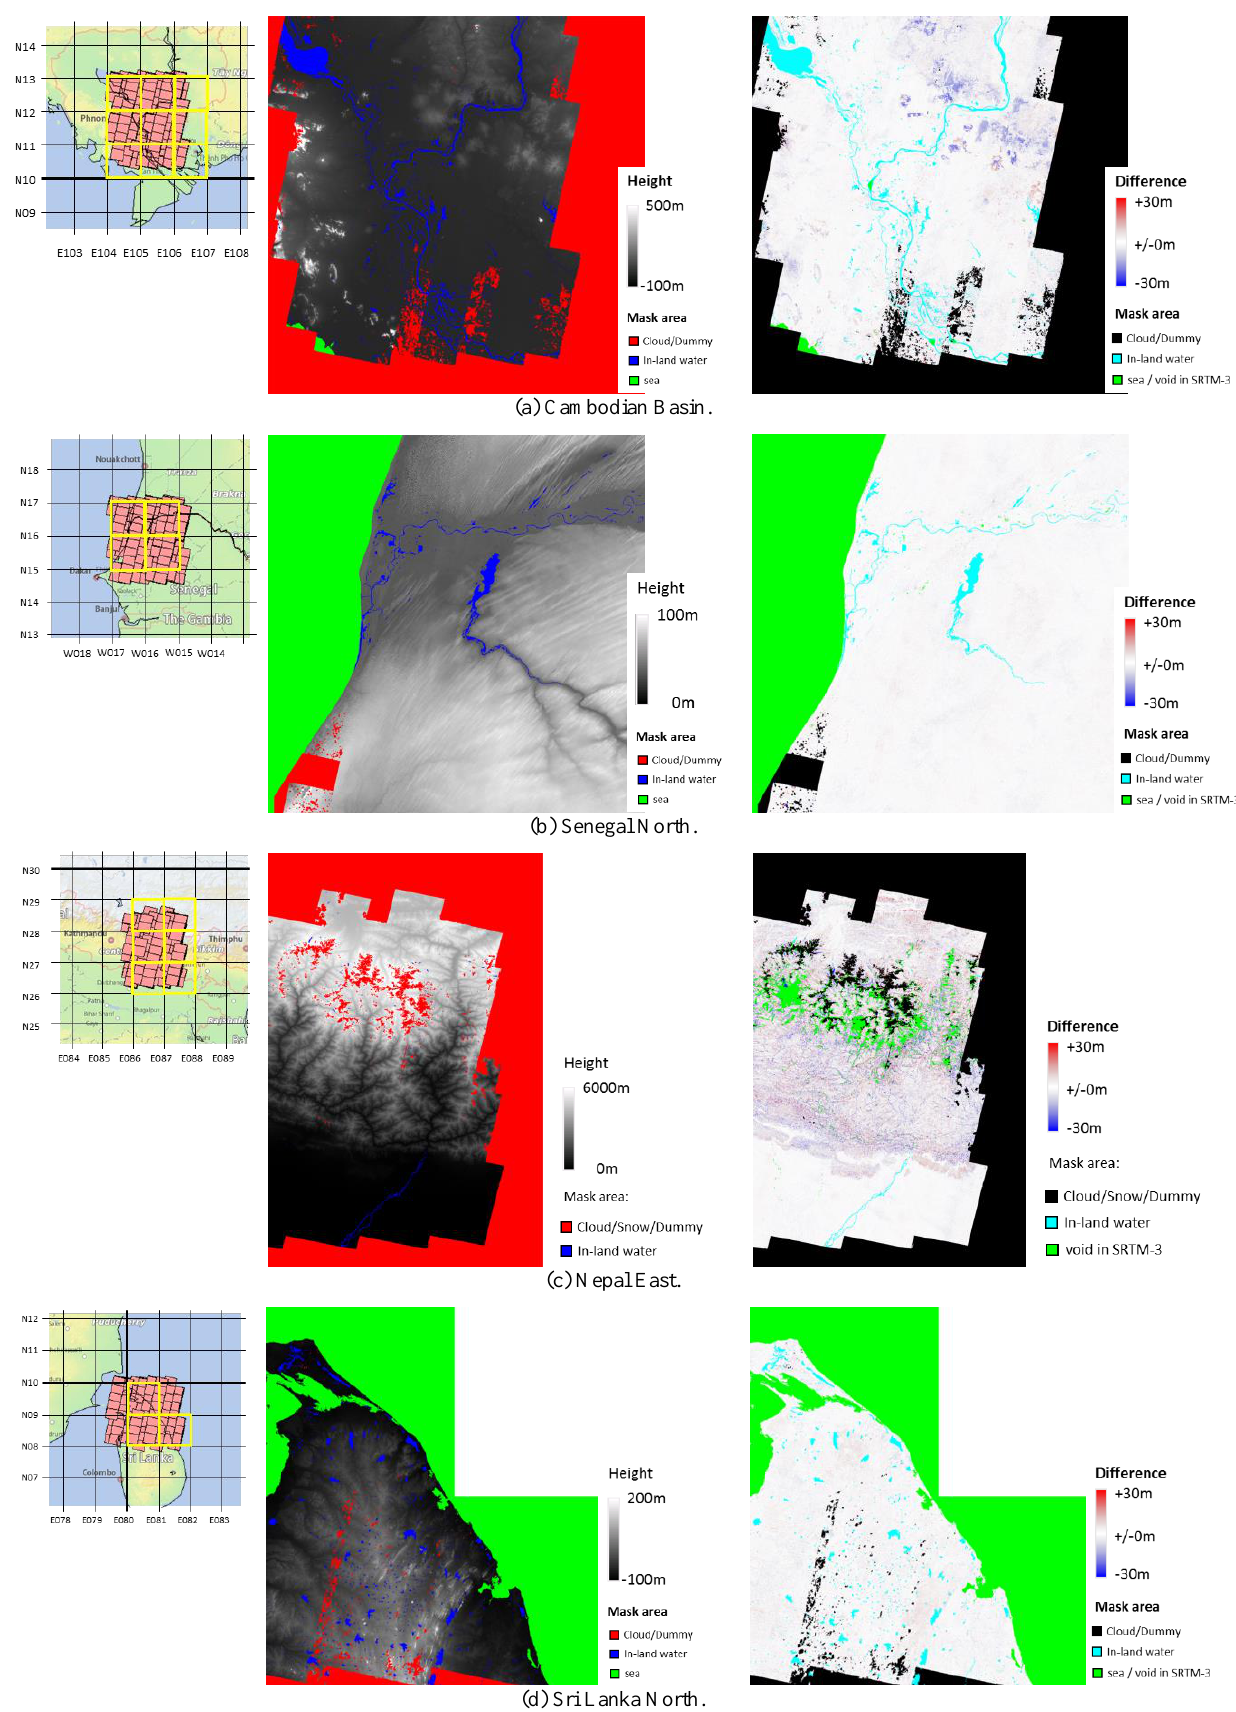
Figure 8. Test site locations (left) and the object DSM tiles (yellow squares) for the test processing, results of the large-scale area PRISM DSM (middle), and the height difference image of PRISM DSM minus SRTM-3 version 2